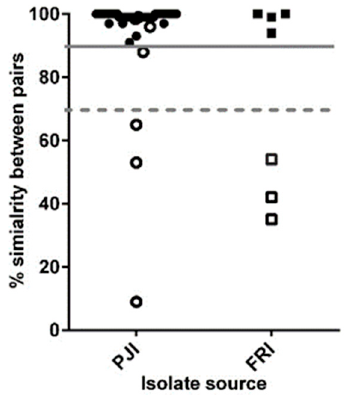
Figure 2. Graph showing the percentage allelic similarities in 522 core genes from 55 patients (115 isolates) based on the isolate source. Each point represents the similarity of successive isolates compared to the original isolate (paired isolates). The unbroken line indicates the 90% similarity cut-off point, hashed line the 70% similarity cut-off point, and open shapes signify patient isolate pairs with different MLST types.